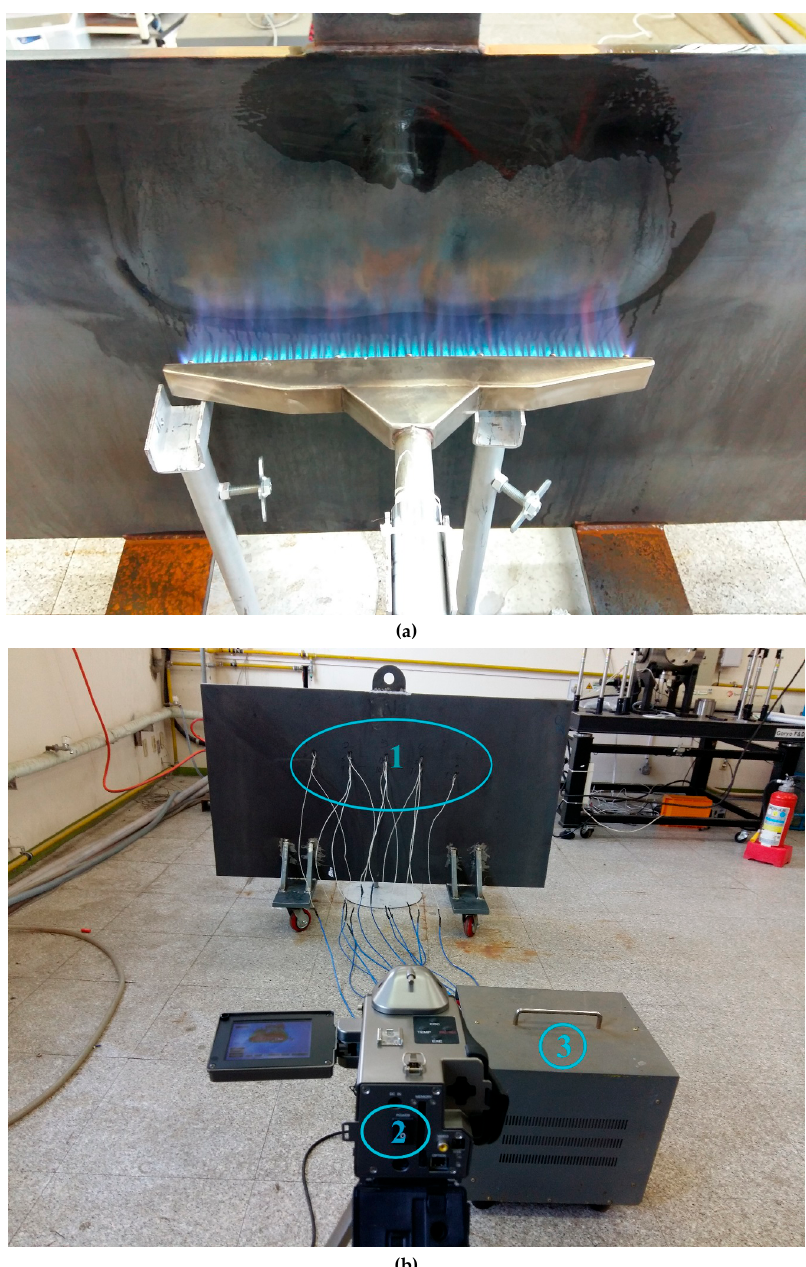
Figure 5. Experimental setup: ( a ) Front side; ( b ) Back side (1: Thermocouples, 2: TVS-200EX infrared camera, 3: Recorder for thermocouples).